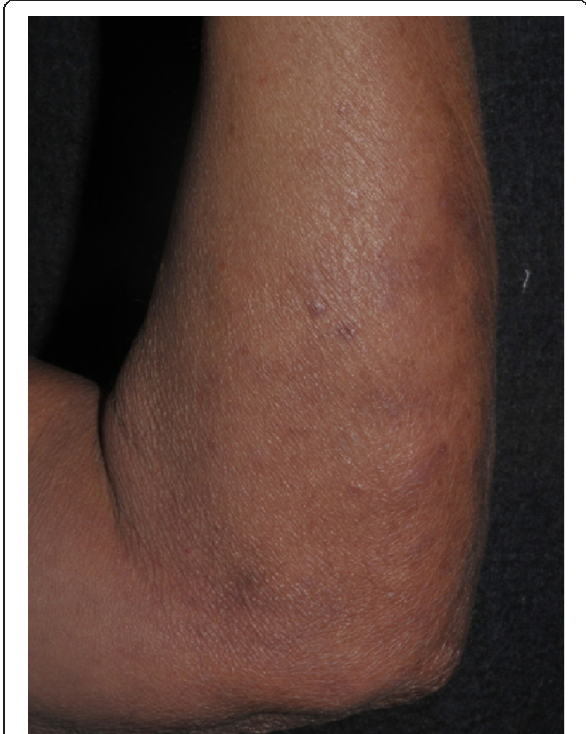
Figure 2 Lepromatous leprosy: erythematous papules and nodules on the upper limbs.